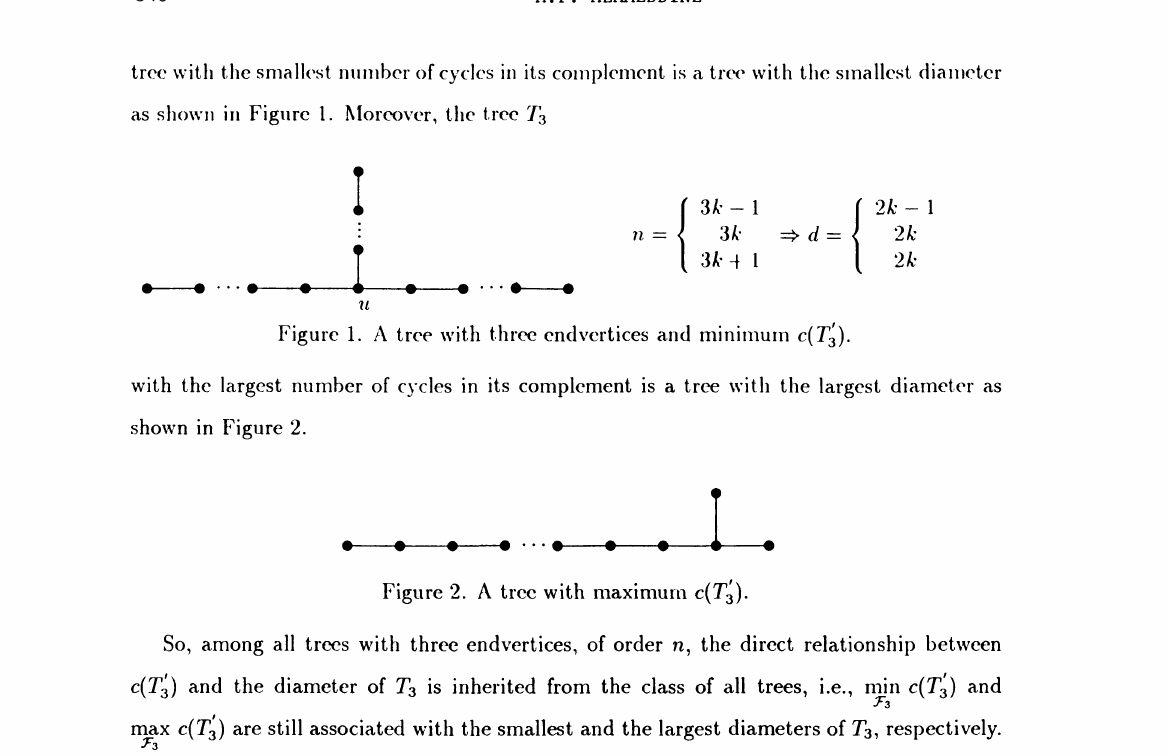
Figure 2. A tree with maximum